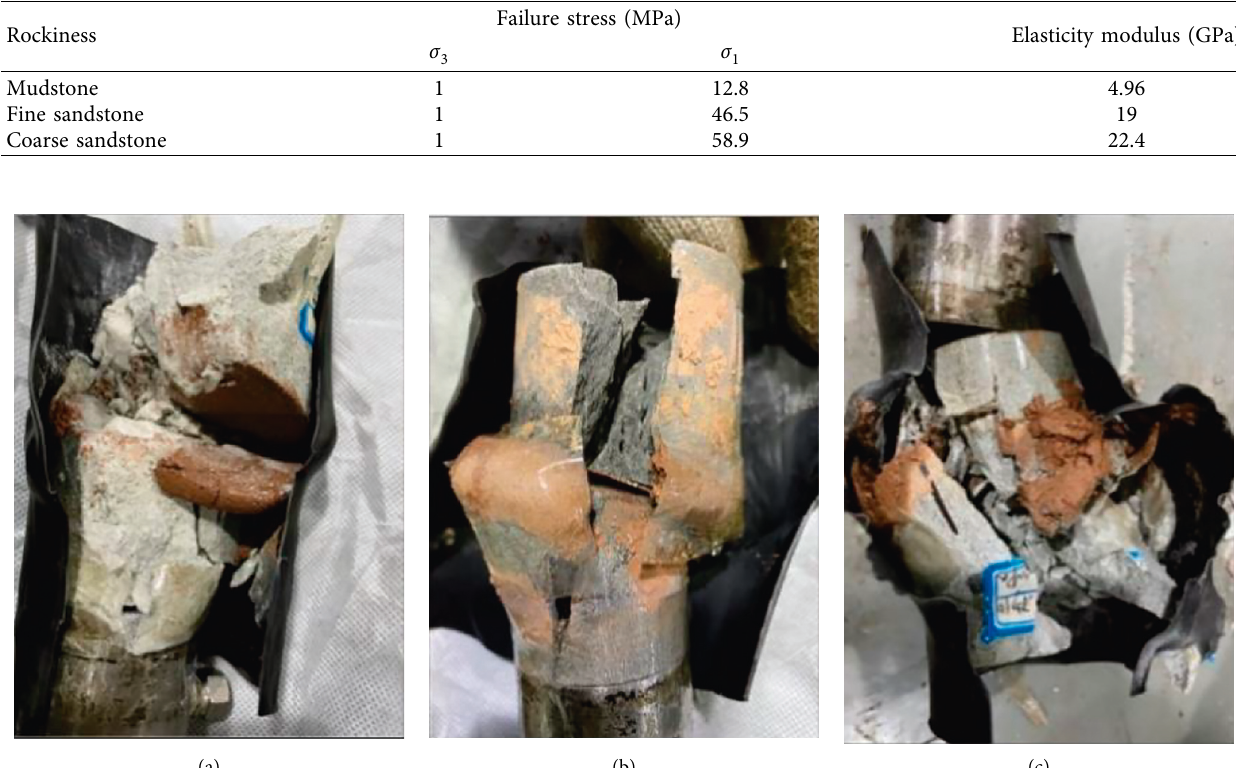
Figure 12: Slippage and macroscopic failure characteristics of structural surfaces with different lithology specimens: (a) mudstone specimen, (b) fine sandstone specimen, and (c) coarse sandstone